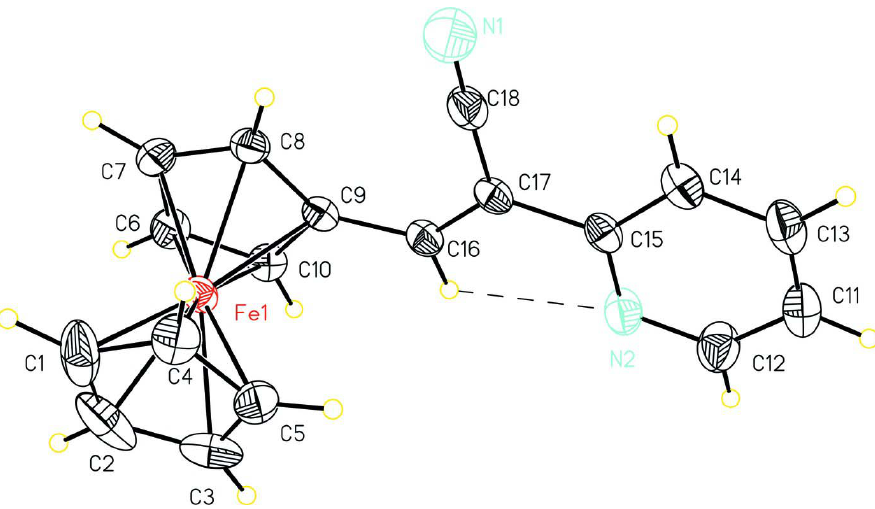
Figure 1 The molecular structure of the title compound, with displacement ellipsoids drawn at the 30% probability level. Hydrojen bond are shown as dashed